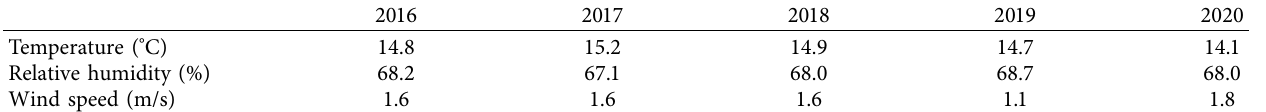
Figure 1: Geography of the study area: (a) the overall location of the study area; (b) the specific location of the study area. Table 1: Annual average of meteorological factors in the study area for